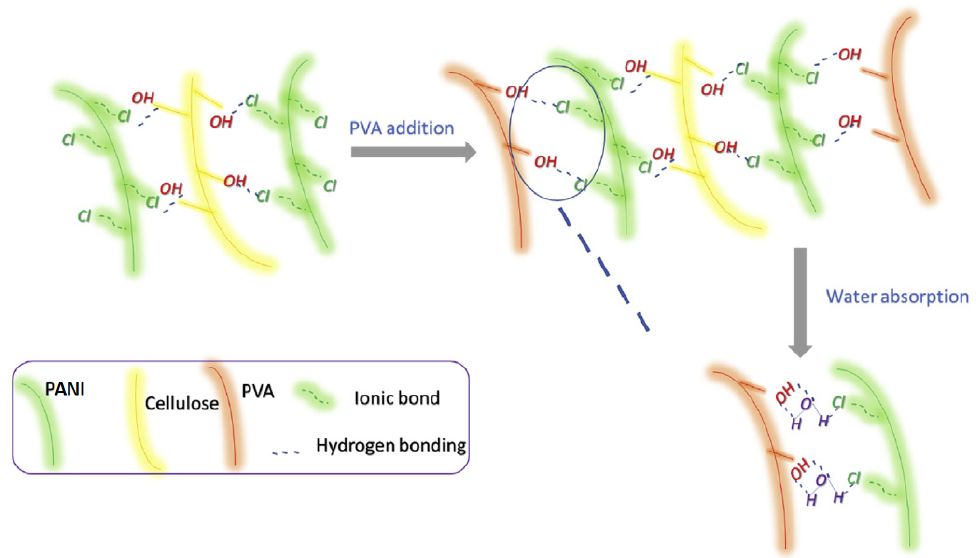
Figure 13. An illustration of the conceptualized structure of a PANI/NFC/PVA composite, to account for its humidity sensitivity. Reprinted with permission from [12]. Copyright 2019, Elsevier.